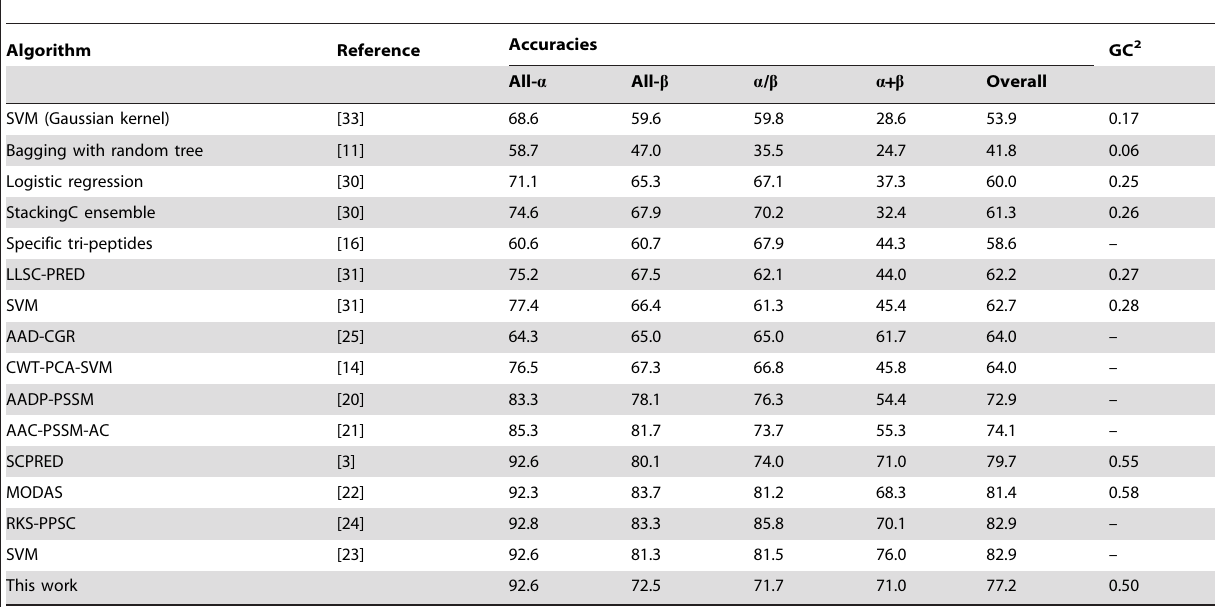
Table 3. Comparison of the jackknife test results between our method and other competing structural class prediction methods using the 25PDB